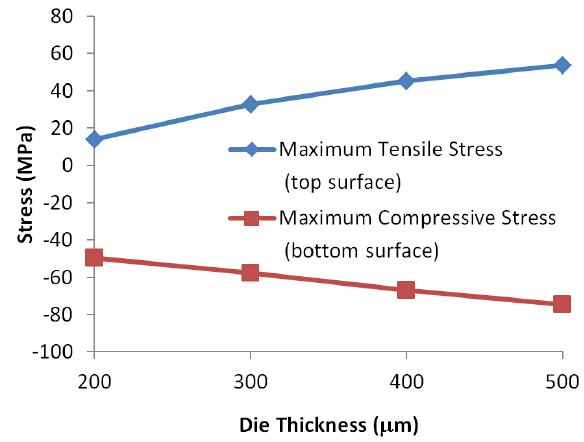
Figure 16. Effect of different die thickness on the maximum stress at die surfaces.